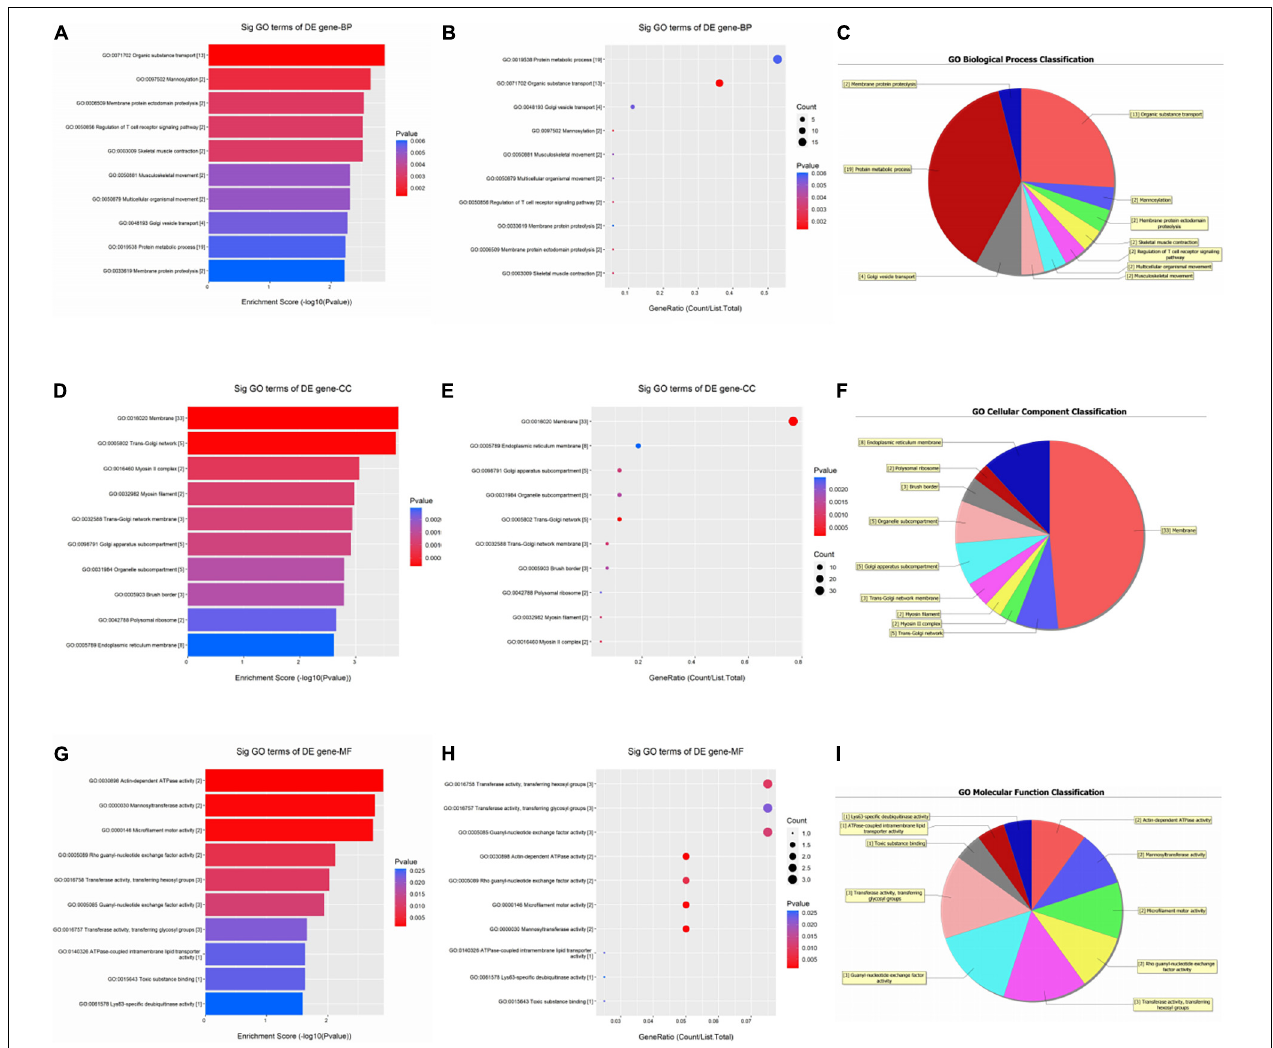
FIGURE 2 | Gene ontology (GO) enrichment analysis of upregulated circRNAs. For bubble plot, the y-axis shows the enriched terms in three GO categories and the x-axis shows the Enrichment Score [ − log10( P -value)] or GeneRatio (Count/List. Total): (A,B) biological process, (D,E) cellular component, (G,H) molecular function. Pie chart shows the distribution of significantly GO terms: (C) biological process, (F) cellular component, (I) molecular